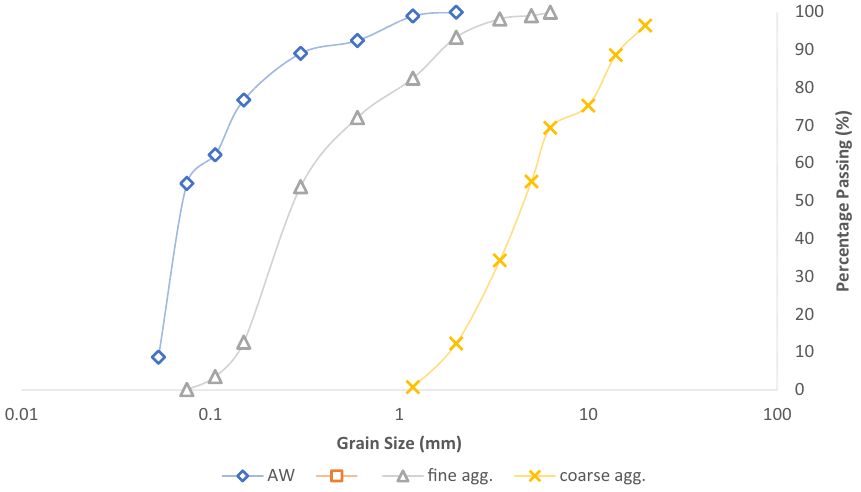
Figure 3. AW, fine and coarse aggregates sieve analysis.